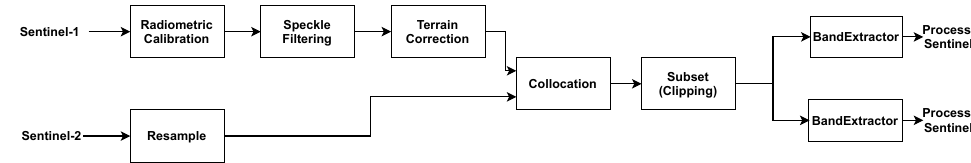
Figure 6. SNAP processing pipeline for collocated Sentinel-1 and